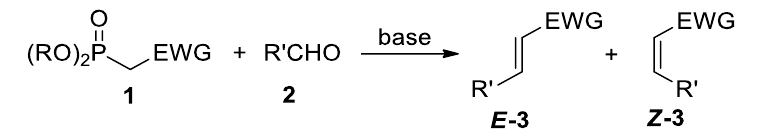
Figure 1. Comparison of Z -selective reagents for the HWE reaction [11 – 14]. Still – Gennari and Ando-type reagents constitute important tools for the Z -selective alkene formation. However, examples from a total synthesis of biologically active, com- plex molecules show that achieving high Z -selectivity using these reagents is not always easy and the outcome of the olefination reactions is highly dependent on the reaction con- ditions and the type of reagent used [19]. Therefore, it would be desirable to broaden the scope of reliable Z -selective carbonyl olefination reagents in order to improve our syn- thetic toolbox. The Z -selectivity of Still – Gennari olefination is a result of the kinetic control of the reaction. An electron-withdrawing effect of R groups (Scheme 1), such as 2,2,2-trifluoro- ethyl or phenyl, favors the Z -selective course of the reaction in contrast to standard E - selective HWE reaction where R is usually the ethyl group (pK a of 2,2,2-trifluoroethanol is 12.4 and pK a of phenol is 10, while pK a of ethanol is 16). The correlation between the electron-withdrawing effect of the R group and the stereoselectivity of the reaction was investigated in more detail by Motoyoshiya and coworkers [9]. Moreover, steric hindrance of R groups may further affect Z -selectivity as in the case of Ando-type reagents bearing aryl substituents. In our previous study, we reported a very simple protocol for the synthesis of Still – Gennari and Ando-type phosphonates [20]. We also reported the synthesis of new phos- phonate reagents bearing 1,1,1,3,3,3-hexafluoroisopropyl R groups. These compounds are